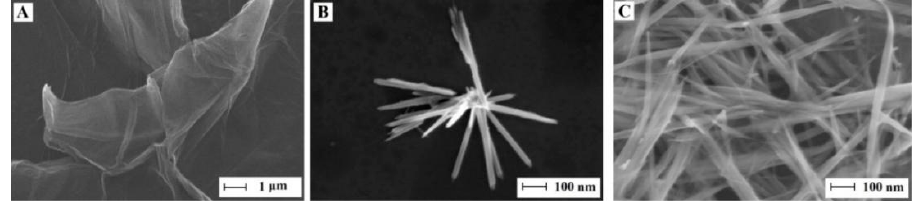
Figure 1. SEM images of GO ( A ), MnO 2 NRs ( B ), and MnO 2 NRs-ERGO ( C ).